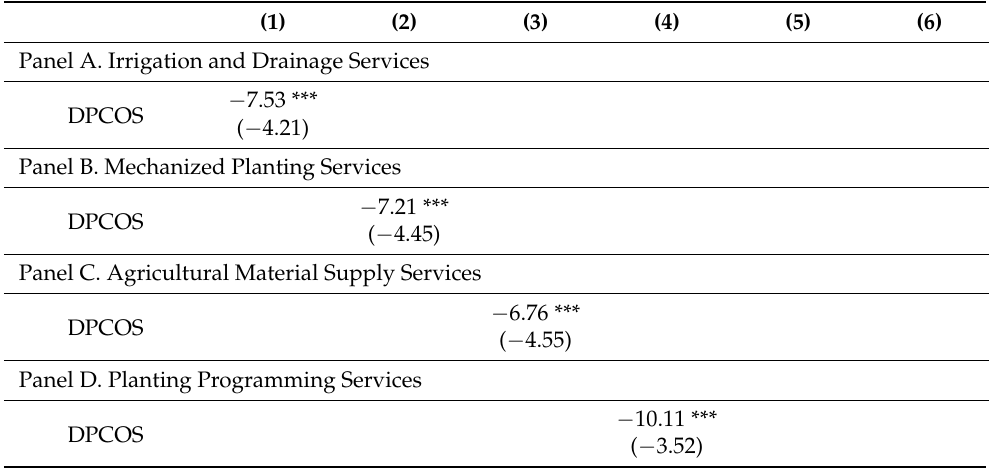
Table 6. Inclusion of other